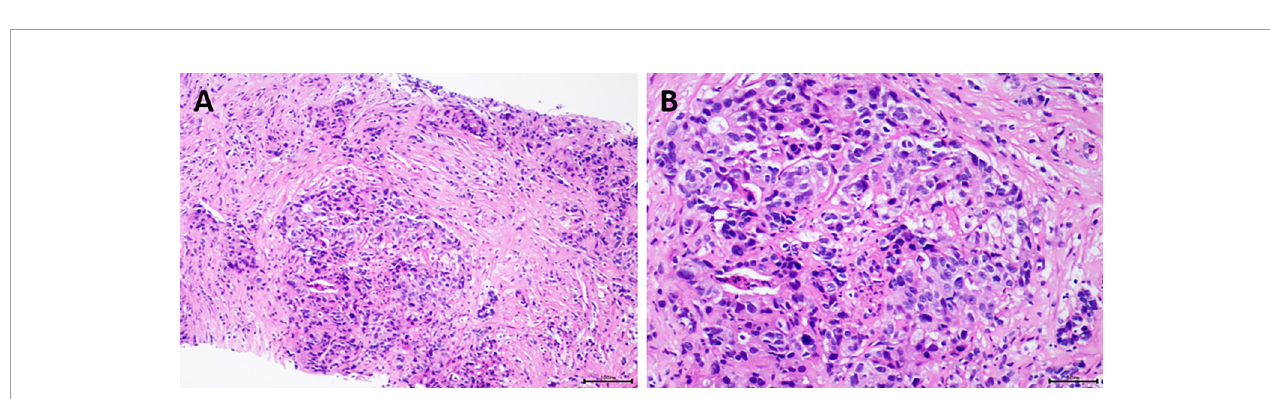
FIGURE 4 | Pathological examination of the patient revealed poorly differentiated adenocarcinoma. (A) Hematoxylin and eosin (H&E), original magni fi cation ×100; (B) H&E, original magni fi cation